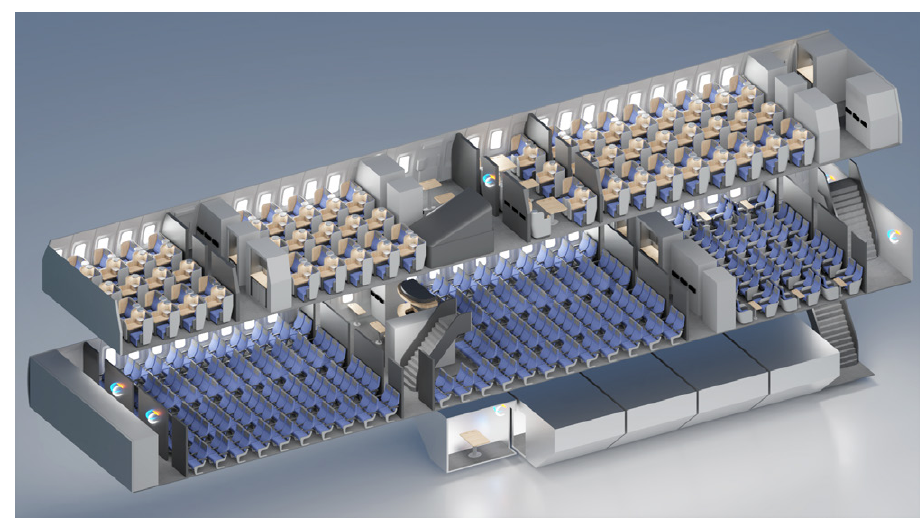
Figure 4. Illustration of three-deck cabin layout (Engelmann et al.,